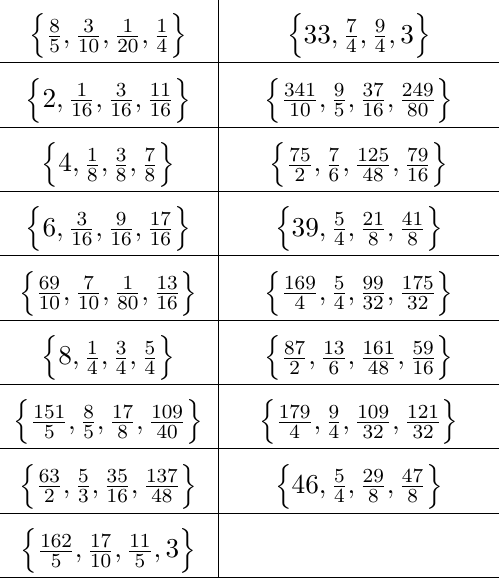
Table 4 . Rank 2 non-degenerate theories with ‘ = 0 that are not unitary and seem to be